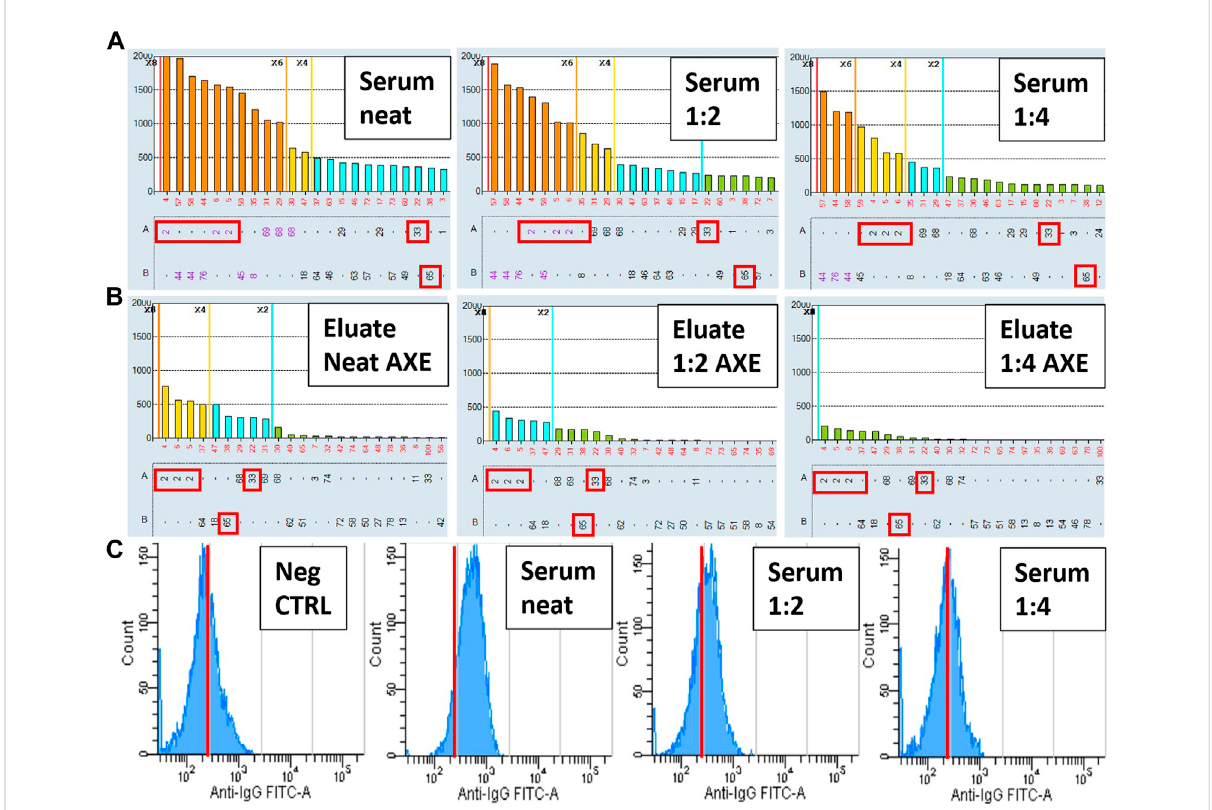
FIGURE 10 The AXE protocol exhibits increased sensitivity and provides improved speci fi city compared to the FCXM assay. SAB images of Class I HLA speci fi cities in a sensitized patient ’ s serum (A) and the AXE eluates using cells from a surrogate donor (B) , are shown. Serum was tested by SAB and adsorbed/eluted using the AXE protocol at three concentrations (neat, 1:2 and 1:4). Mean fl uorescence intensity (MFI) values are displayed on the Y axis (A and B) . The SAB HLA speci fi cities ( X axis) are sorted in order of decreasing MFI (A and B) . Mismatched AXE donor speci fi c antigens (HLA- A2, A33, B65) are indicated with red rectangles (A and B) . PanelC depicts histograms ofT cell FCXM performed againstthe AXE donor cells using the negativecontrolserum(leftpanel)andthreeconcentrationsofpatient ’